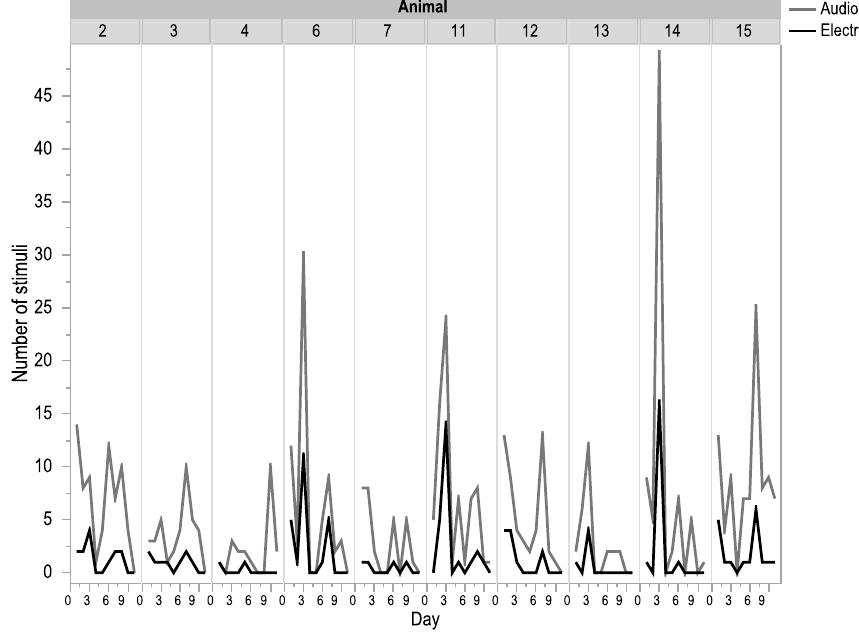
Figure 3. The number of audio and electrical stimuli that each individual animal received during the 10-day period of virtual fence activation. Animal 5 was removed from this dataset as there was a functionality error in the delivery of the electrical stimulus.